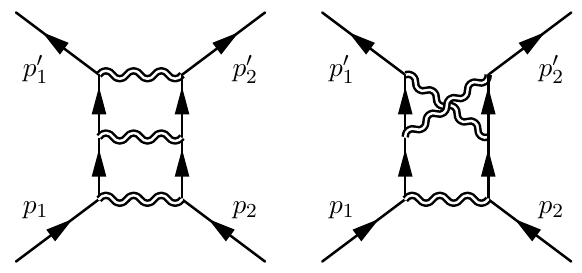
Figure 1 . Double-box and crossed double-box